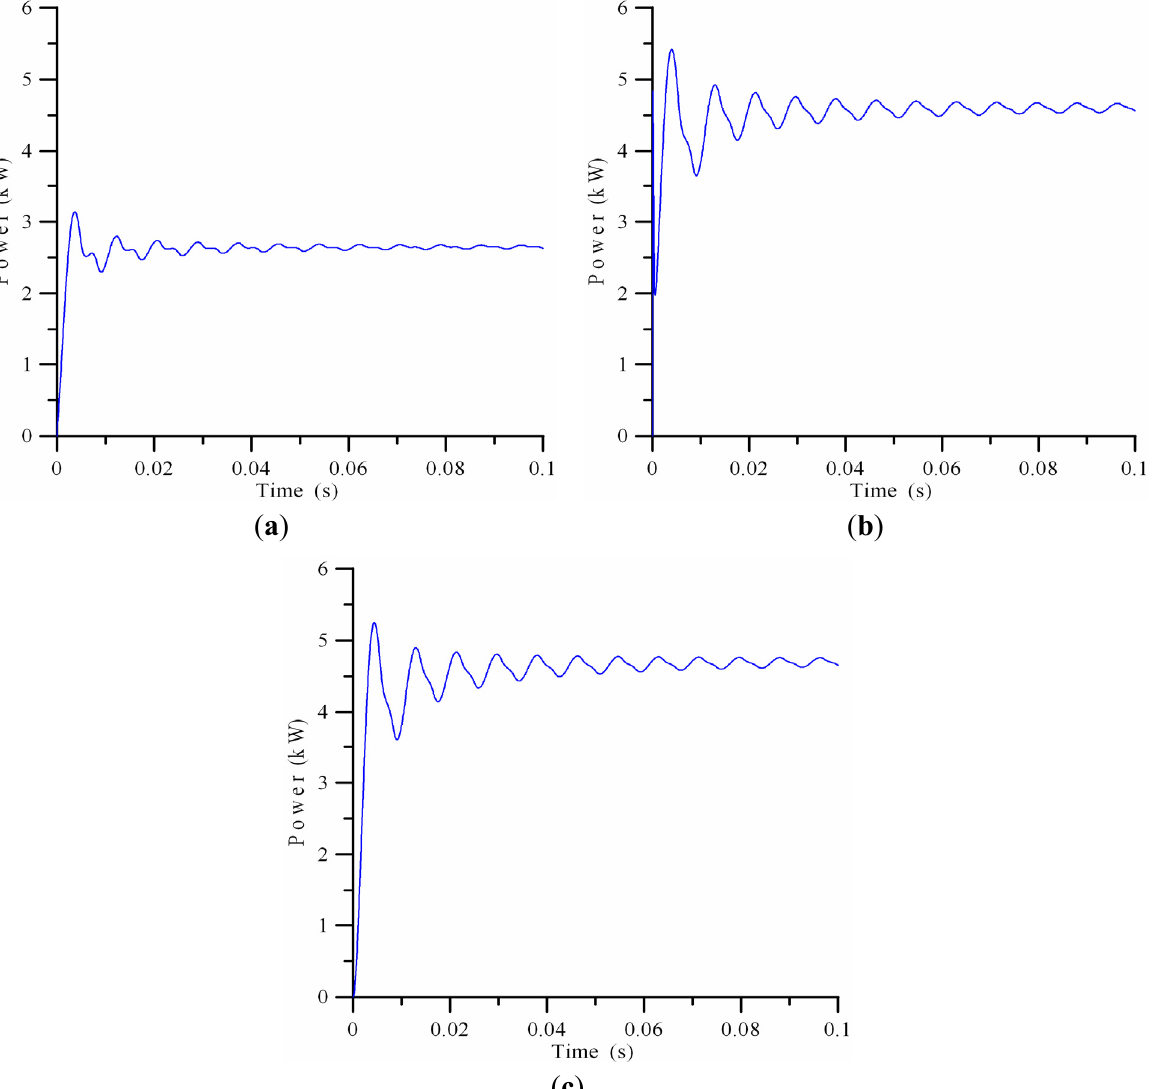
Figure 8. Simulation of load turn-on instantaneous transient power for case 2. ( a ) a 2.6 hp induction motor; ( b ) a 4.7 hp induction motor; ( c ) an R-L linear load with P and Q equivalent to that of a 4.7 hp induction